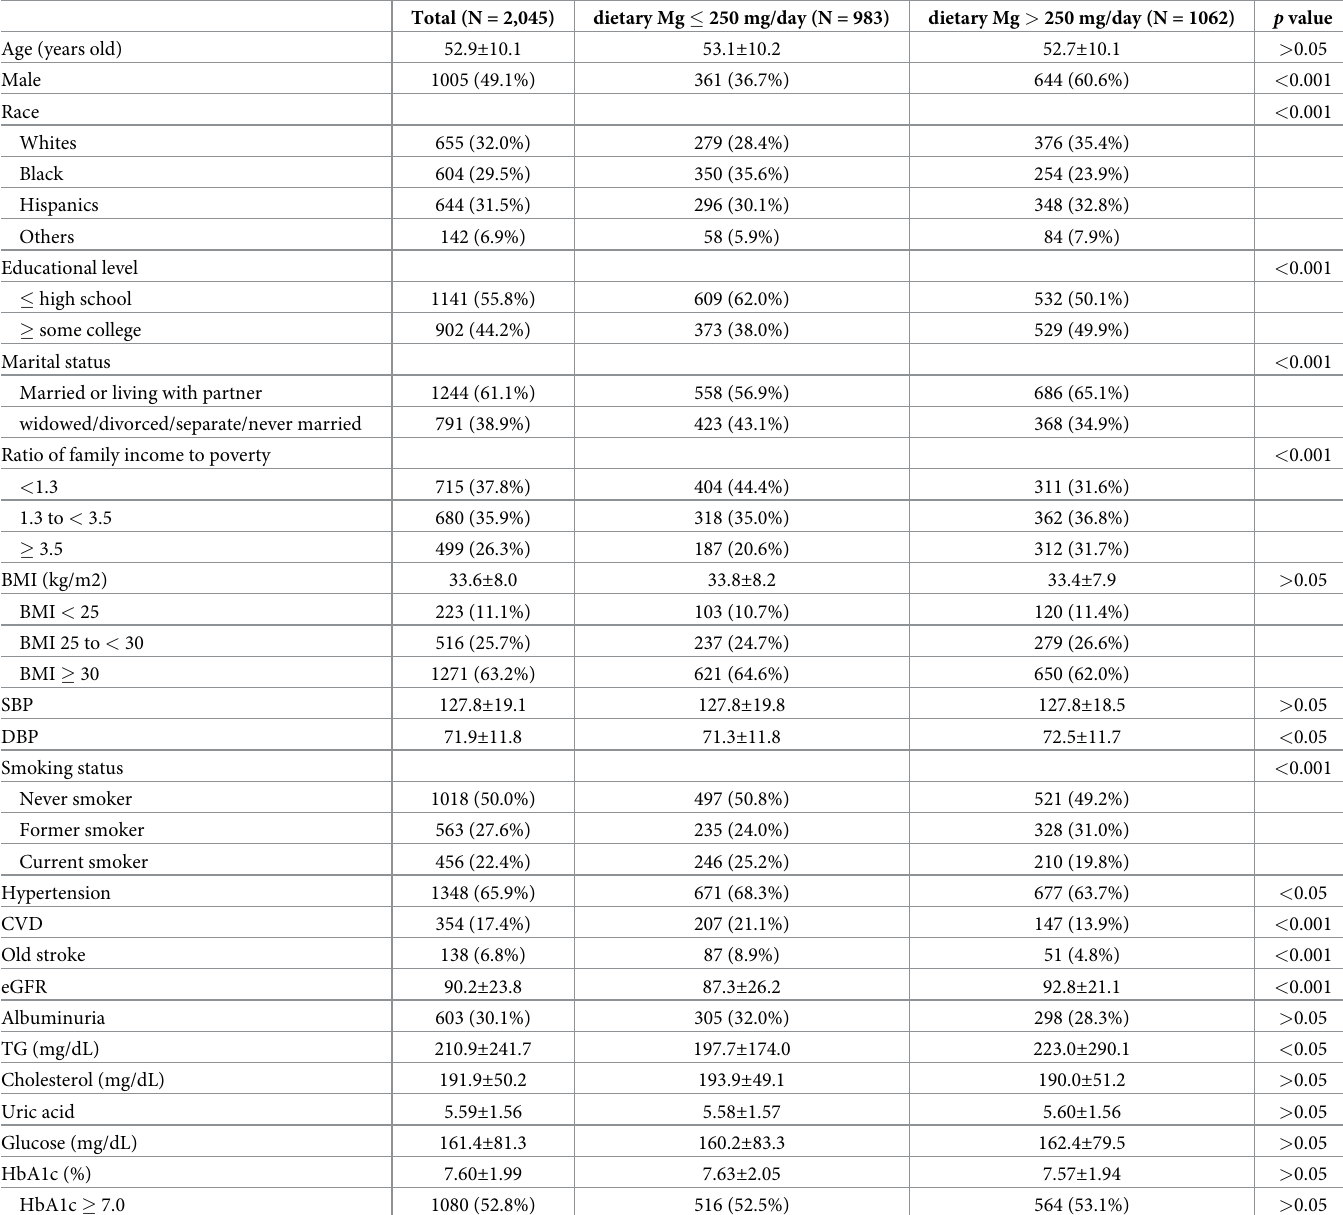
Table 1. Baseline characteristics of the study